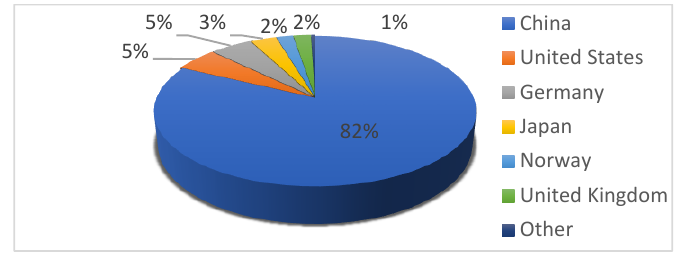
Figure 3. Fast public charging stations globally.